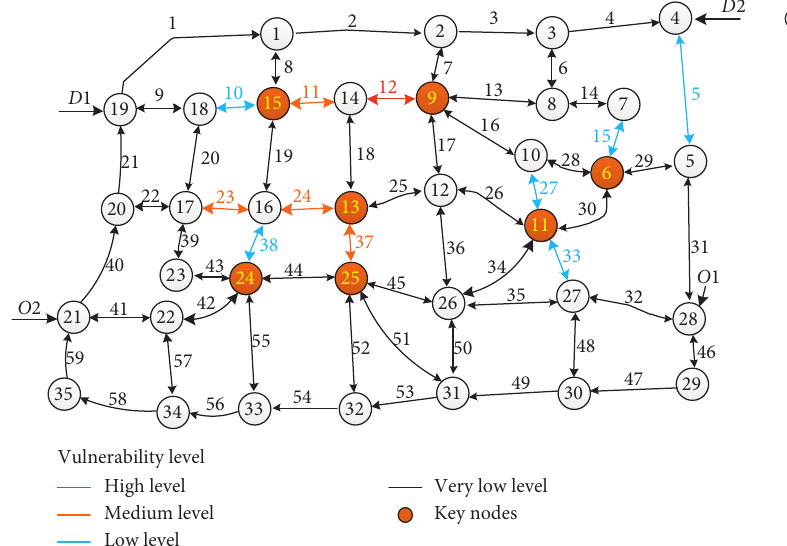
Figure 9: Vulnerability level